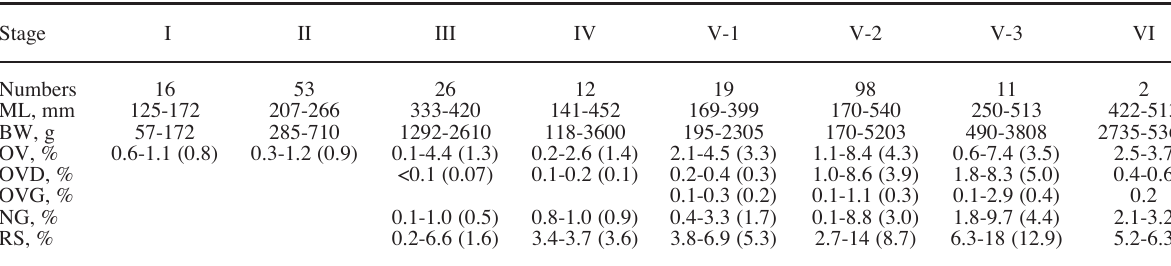
T ABLE 2. – Weight of the reproductive system at different maturity stages expressed as percent of the BW (OV, ovary; OVD, oviducts; OVG, oviductal glands; NG, nidamental glands; RS, total reproductive system) and index of nidamental gland length (NGL) in % of ML; Mean values in